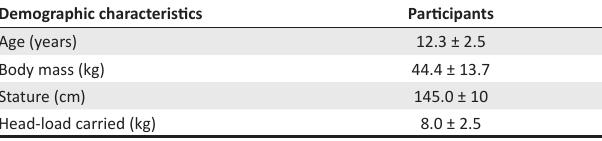
TABLE 1: Demographic details of participants ( n = 100).